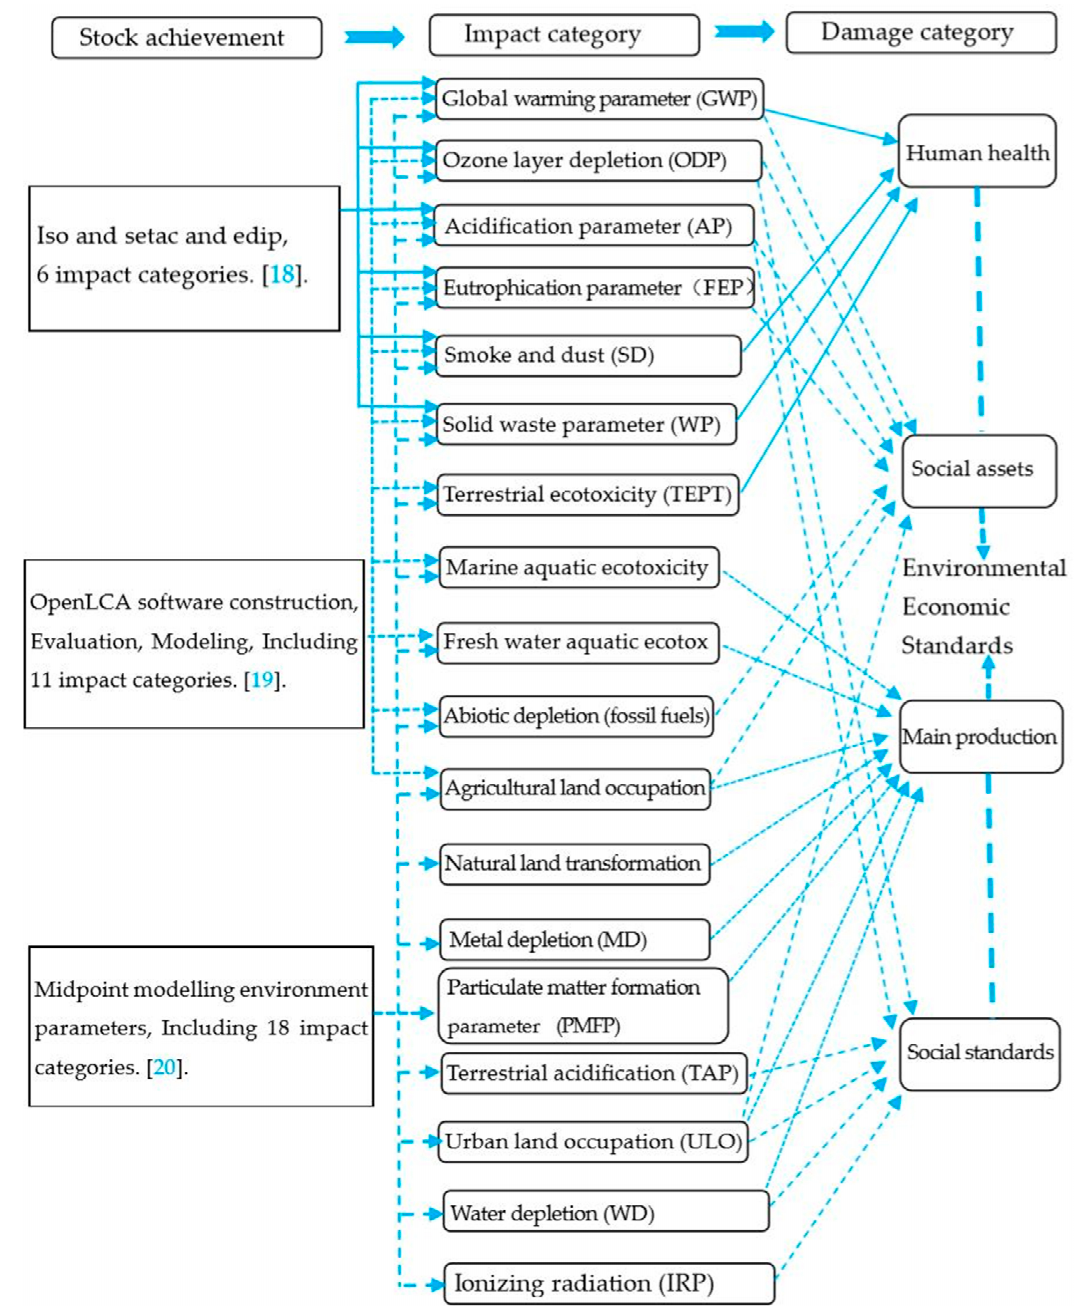
Figure 2. Schematic diagram of inventory and damage categories of construction materials’ life cycle list. ISO: International Organization for Standardization, SETAC: International Society for Environmental Toxicology and Chemistry, EDIP: Danish Industrial Product Environmental Design